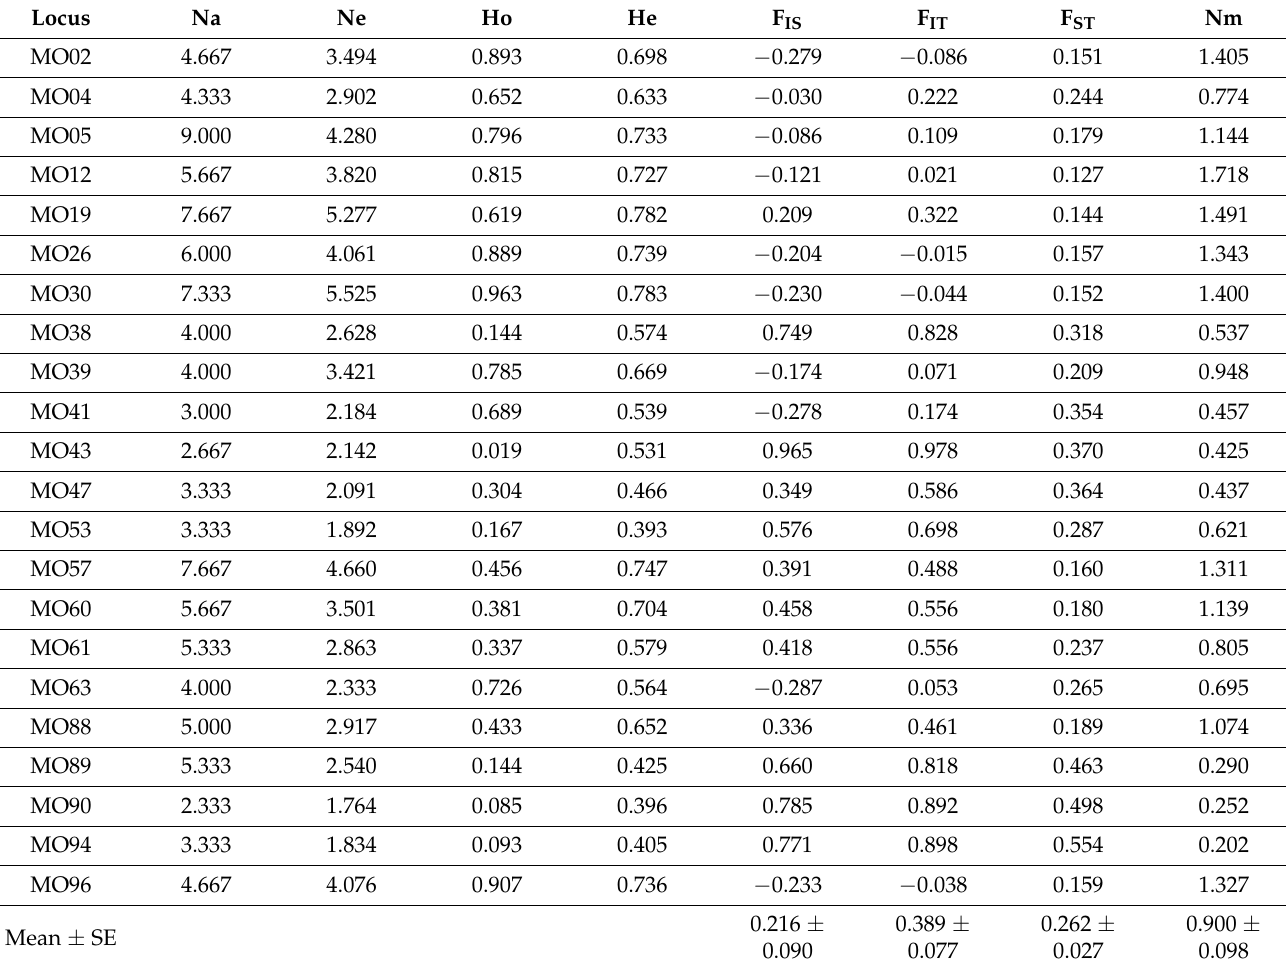
Table 9. Genetic diversity characteristics of 22 microsatellite loci of M. officinalis .